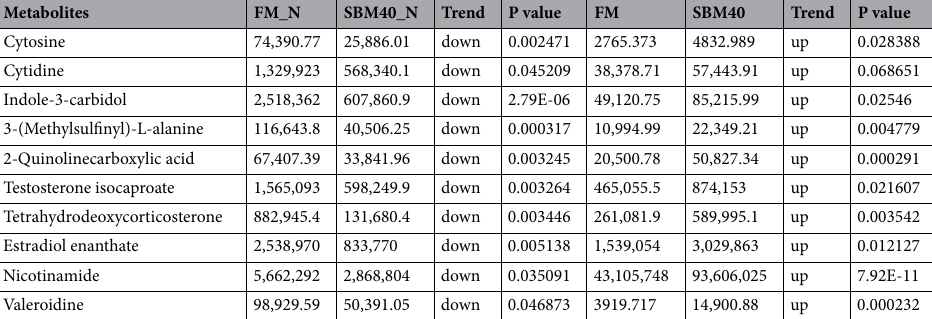
Table 10. 10 representative metabolites of the intensities decreased significantly in DI contents and increased significantly in DI tissues (n = 12). Same as Table